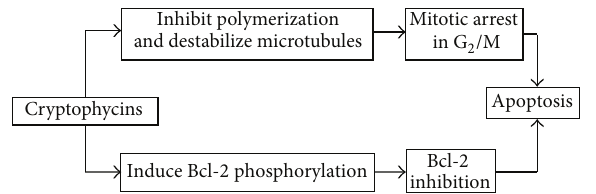
Figure 2: Mechanism of action of cryptophycins.